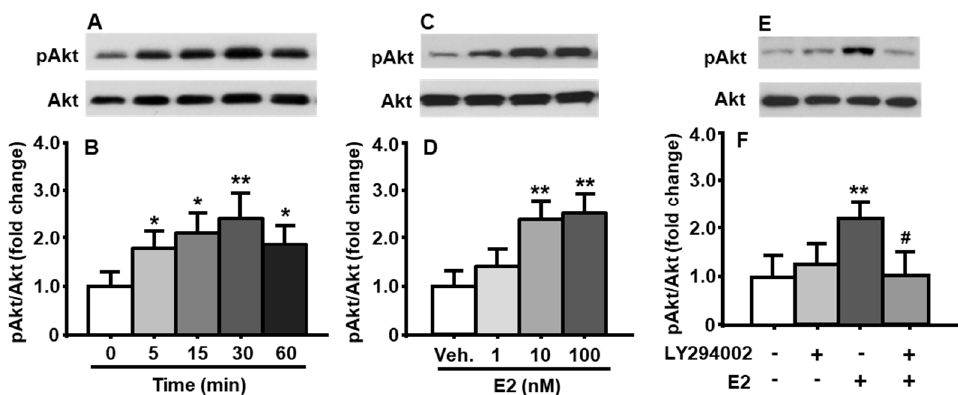
Figure 1. PI3K / Akt signaling pathway in cultured neuronal cells was significantly activated by E2. E2 at a concentration of 10 nM time-dependently increased the phosphorylation of Akt ( A , B ). When treated for 30 min, E2 concentration-dependently increased the ratio of pAkt / total Akt ( C , D ). PI3K inhibitor, LY294002 (10 µ M), significantly attenuated E2-induced Akt phosphorylation ( E , F ). Representative immunoblots of pAkt and total Akt are shown in ( A , C , E ); quantitative analysis of the data is presented in ( B , D , F ). Veh.: vehicle (DMSO). Mean ± S.E., n = 3–4. * p < 0.05, ** p < 0.01 compared to pAkt levels at 0 min or vehicle control. # p < 0.05, compared to that in neuronal cells treated with E2 for 15 min.